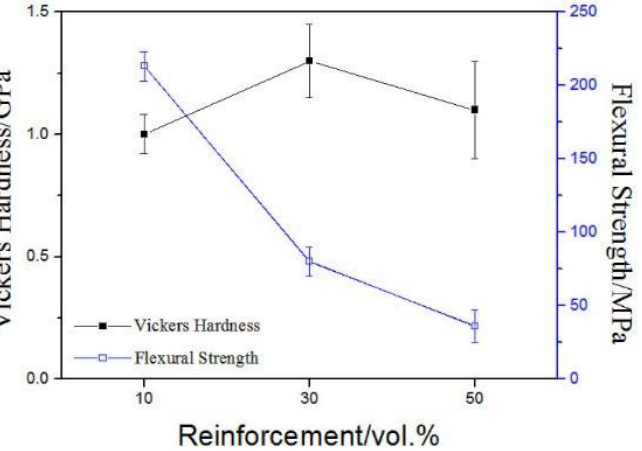
Figure 7. The micro-Vickers hardness and flexural strength of Ti 3 AlC 2 /Cu composites with different volume fractions.